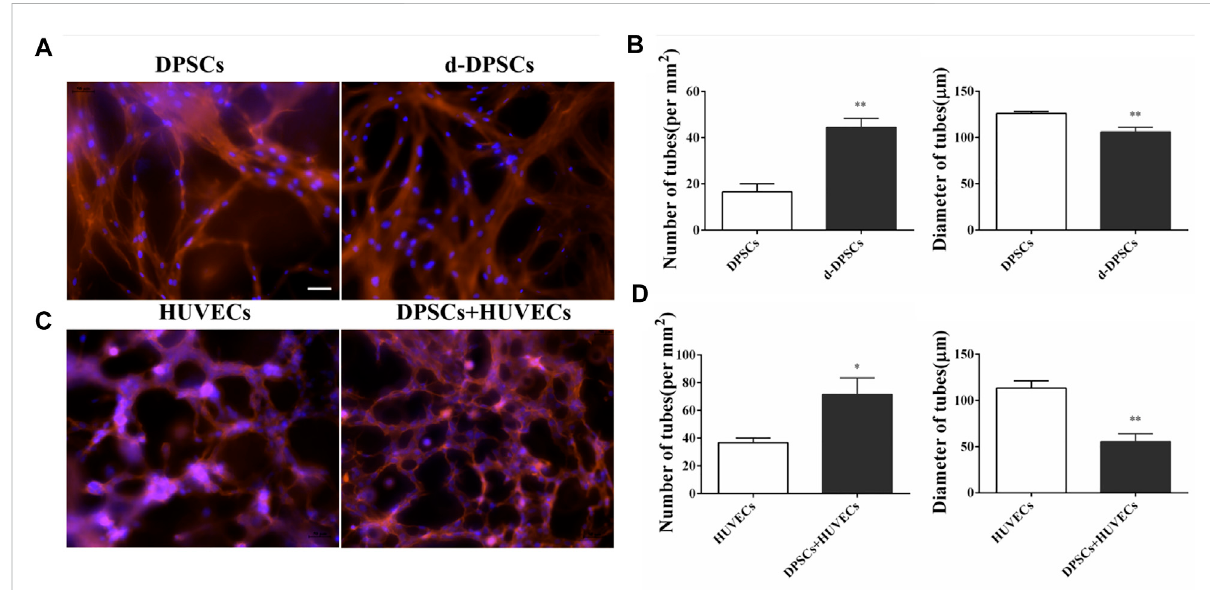
FIGURE 3 The effects of DPSCs on the formation of vessel-like structures. (A) The angiogenic potential of DPSCs by directly induced by EGM-2 TM complete culture medium. (B) The number and diameter of the formed tubes between the DPSCs group and the differentiated DPSCs (d-DPSCs). ** p < .01versustheDPSCsgroup. (C) TheeffectsofDPSCsonthetubeformationofHUVECsbythecoculturedsystem. (D) Thenumberanddiameter oftheformedtubesbetweentheHUVECsgroupandtheHUVECscoculturedwithDPSCsgroup(DPSCs+HUVECs).* p < .05,** p < .01versusthe HUVECs group. Scale bar: 50 μ